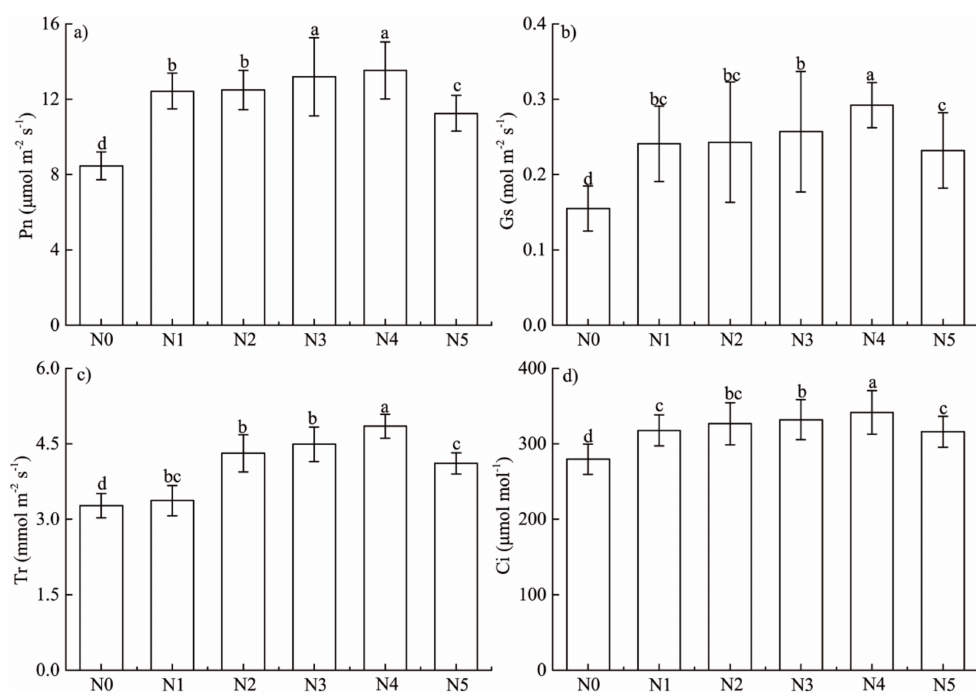
Figure 1. Effects of N treatments on the net photosynthesis rate (Pn, a ), stomatal conductance (Gs, b ), transpiration rate (Tr, c ), and intercellular CO 2 concentration (Ci, d ) in leaves of Cupressus lusitanica Mill. Notes: Values shown are the mean ± S.E. ( n = 3); Different letters indicate significant differences at p < 0.05 among different N treatments.